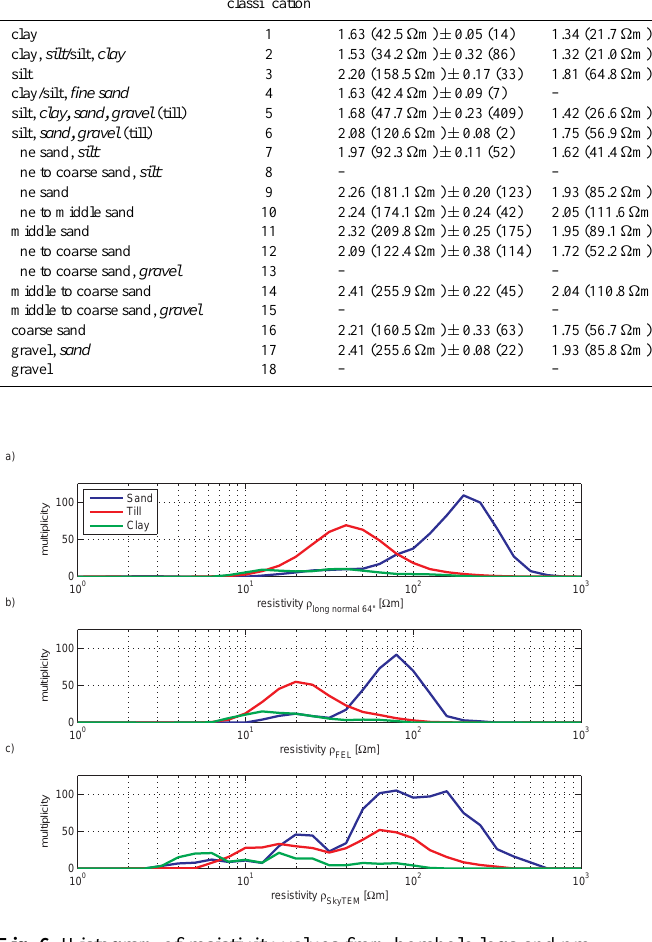
Fig. 7. Histogram of seismic velocities from VSP data for petro- graphical classification of sand, till and clay: (a) P-wave velocities; and (b) S-wave